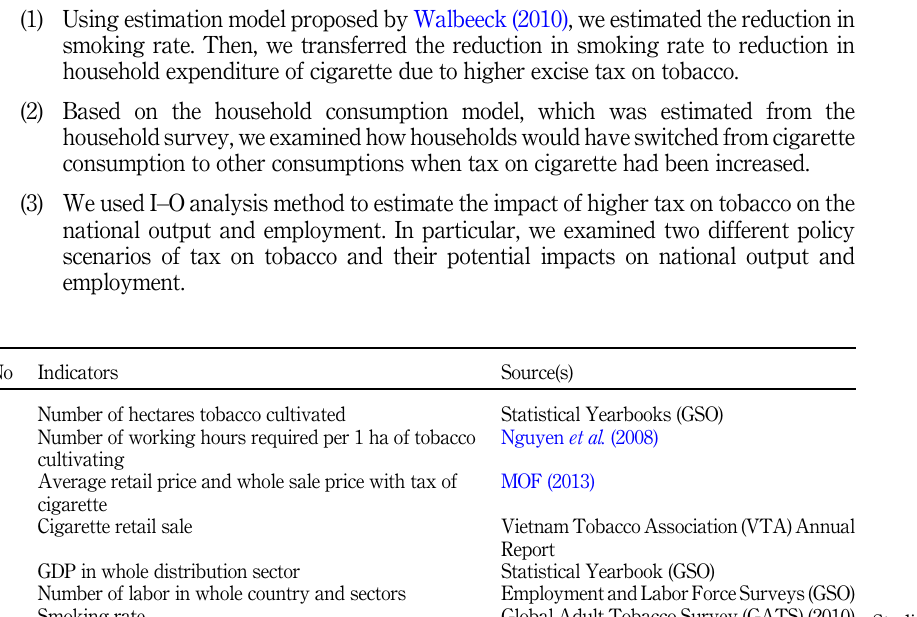
Table 1. Studied indicators and their